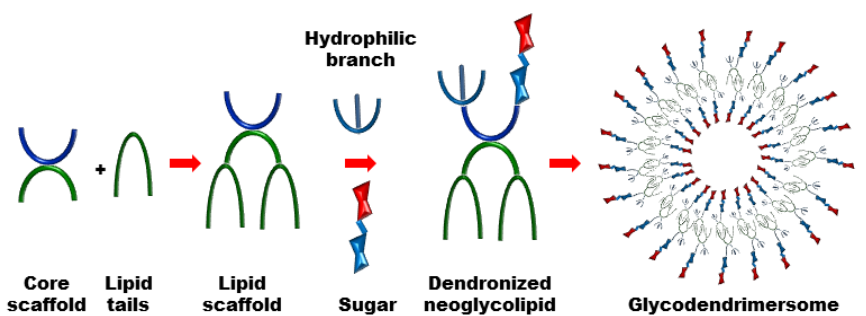
Figure 3. Synthetic strategy and necessary fragments used in the modular construction of seven libraries of 51 dendritic neoglycolipids [30 – 32].